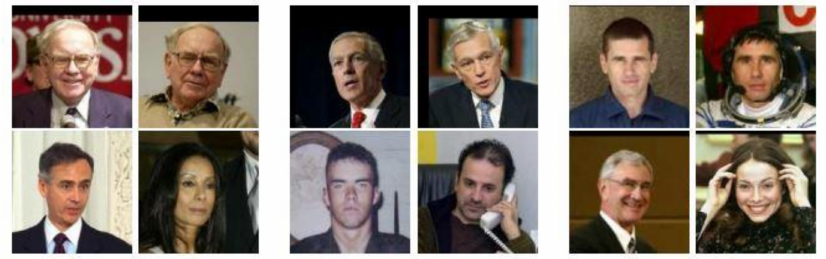
Figure 8. Image examples selected from the LFW dataset.